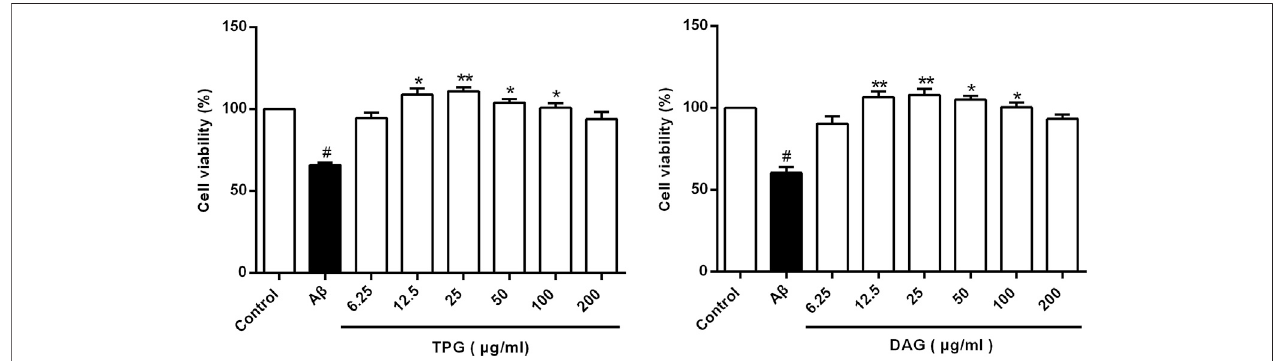
FIGURE 1 | Cells viability of the A β 25 – 35 -exposed cells being treated with TPG and DAG. Statistical analyses were performed using one-way ANOVA and Tukey- HSD post hoc comparisons. All values were shown as mean ± SEM from three independent studies. # p < 0.05, vs. control group; * p < 0.05, vs. A β 25 – 35 models;